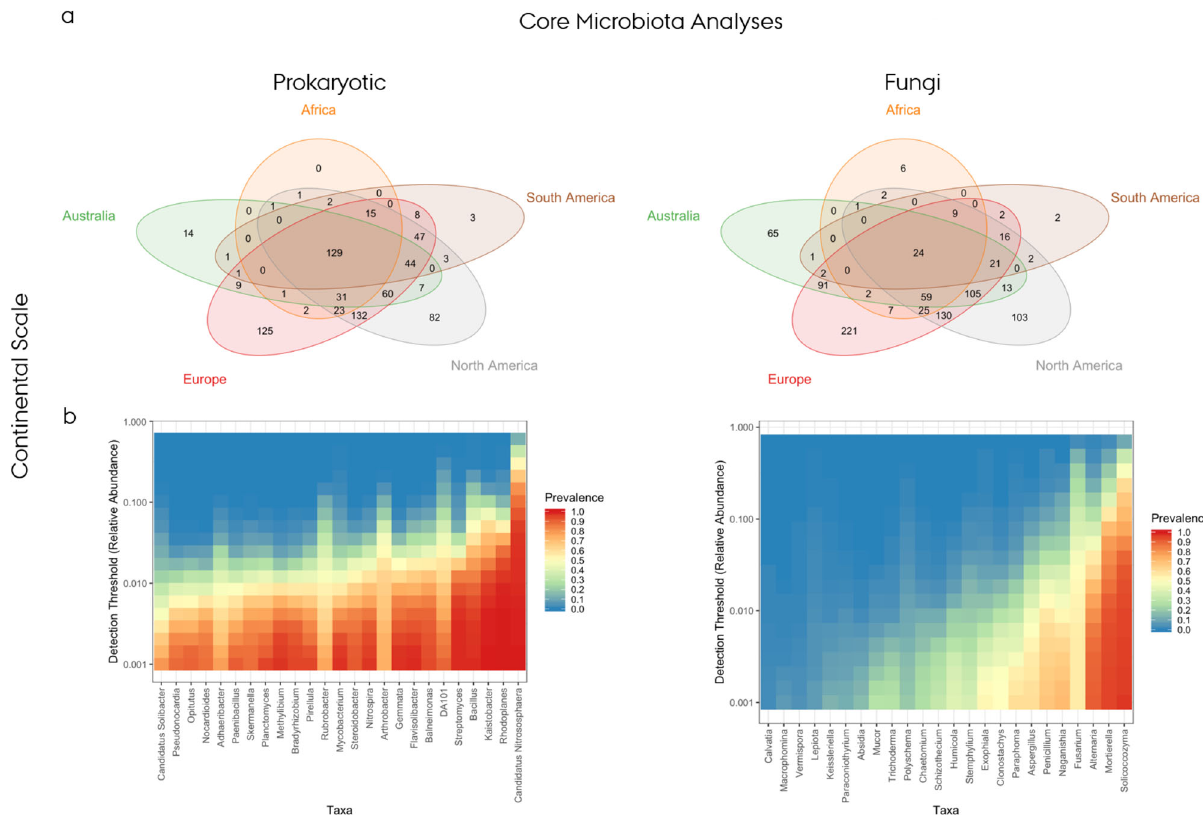
Fig. 2 Evaluation of core microbiota. a Co-occurrence of different genera constituting the core microbiome at continent-level for the prokaryotic (left) and fungal (right) community visualised with Venn diagrams; b Heatmaps for the top 25 genera shared between continents for the prokaryotic (left) and fungal communities (right), including information on their relative abundance and